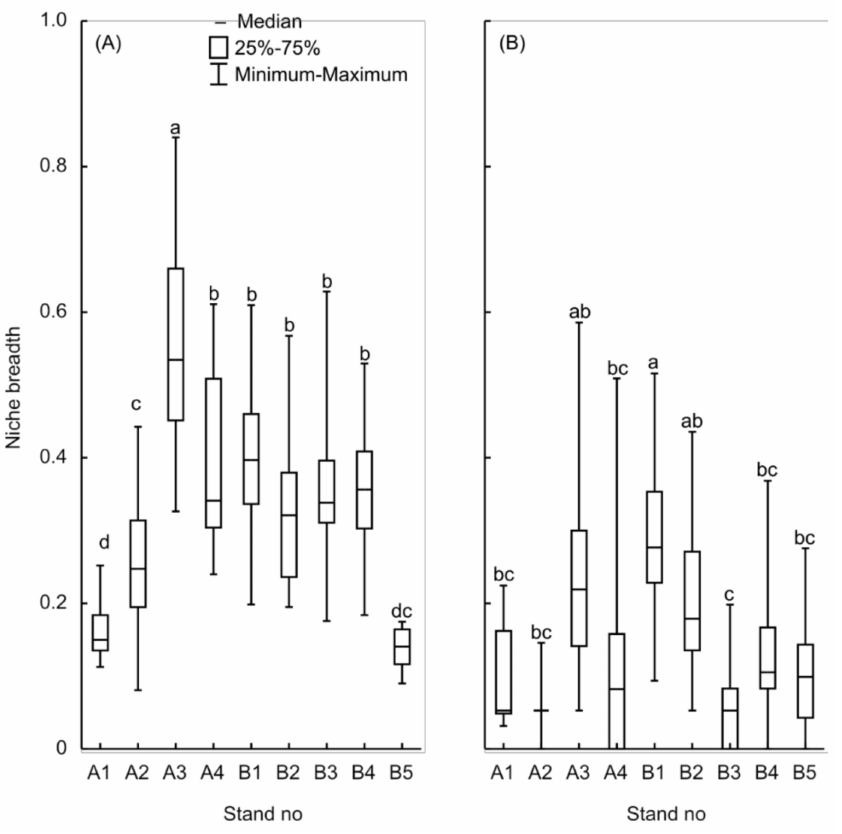
Figure 7. Niche breadth for pine shoot beetles colonizing trap logs ( A ) Tomicus piniperda ( B ) Tomicus minor : a , b , c , d the value of niche breadth (median) marked with different letters indicate statistically significant differences in the stands (Kruskal-Wallis test, p < 0.05).